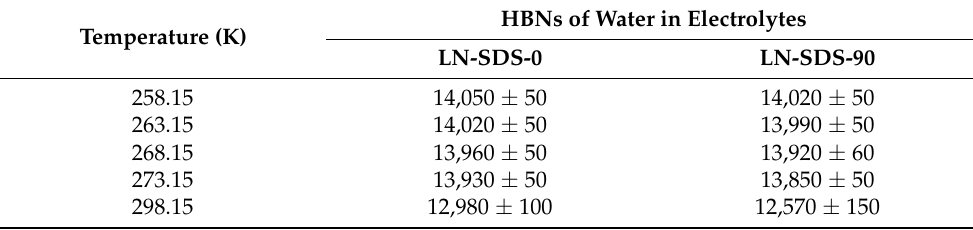
Table 3. HBNs of water in electrolytes in the temperature range of 258.15–298.15 K. Temperature (K)